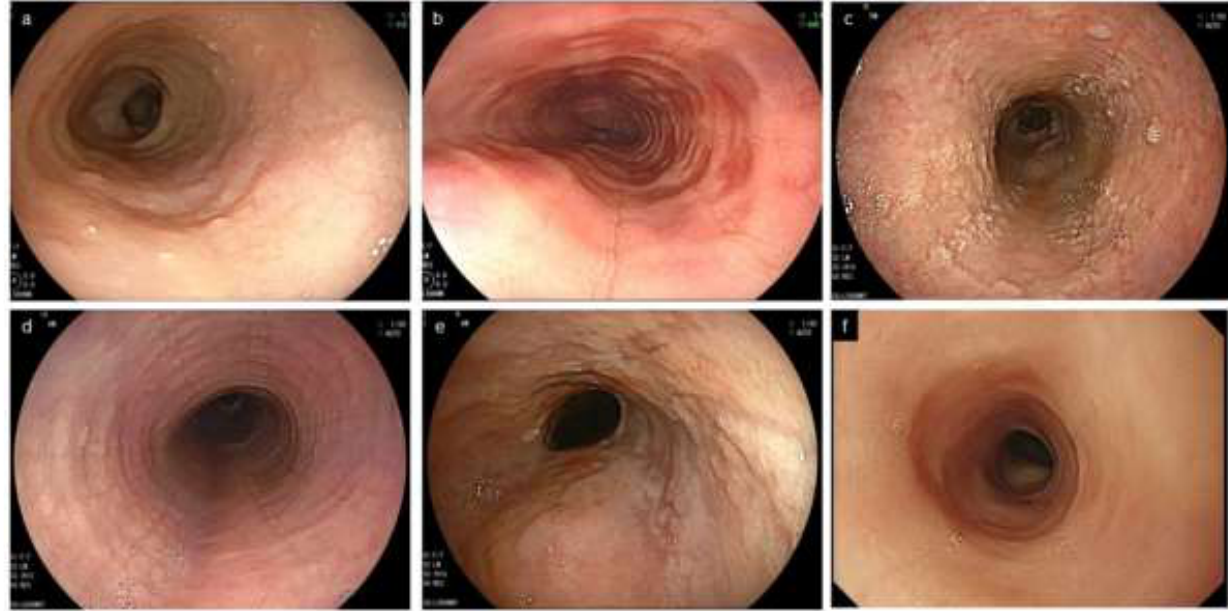
Figure 2. Characteristic endoscopic findings of EoE. ( a ). Edema. Decreased vascularity or loss of it